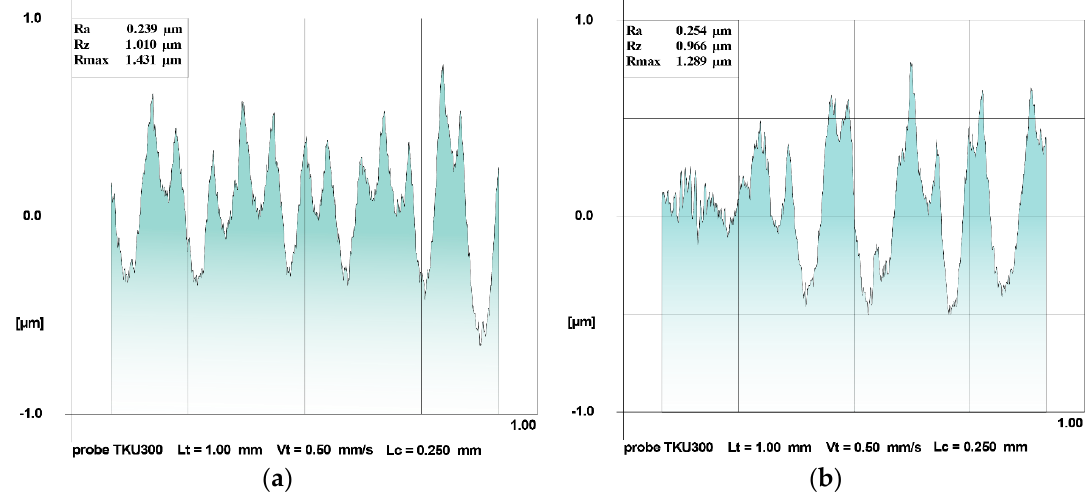
Figure 9. Profiles of the cutting edge radii after etching in four sections distanced from the mill end at 7 mm and distanced from each other at 0.05 mm.